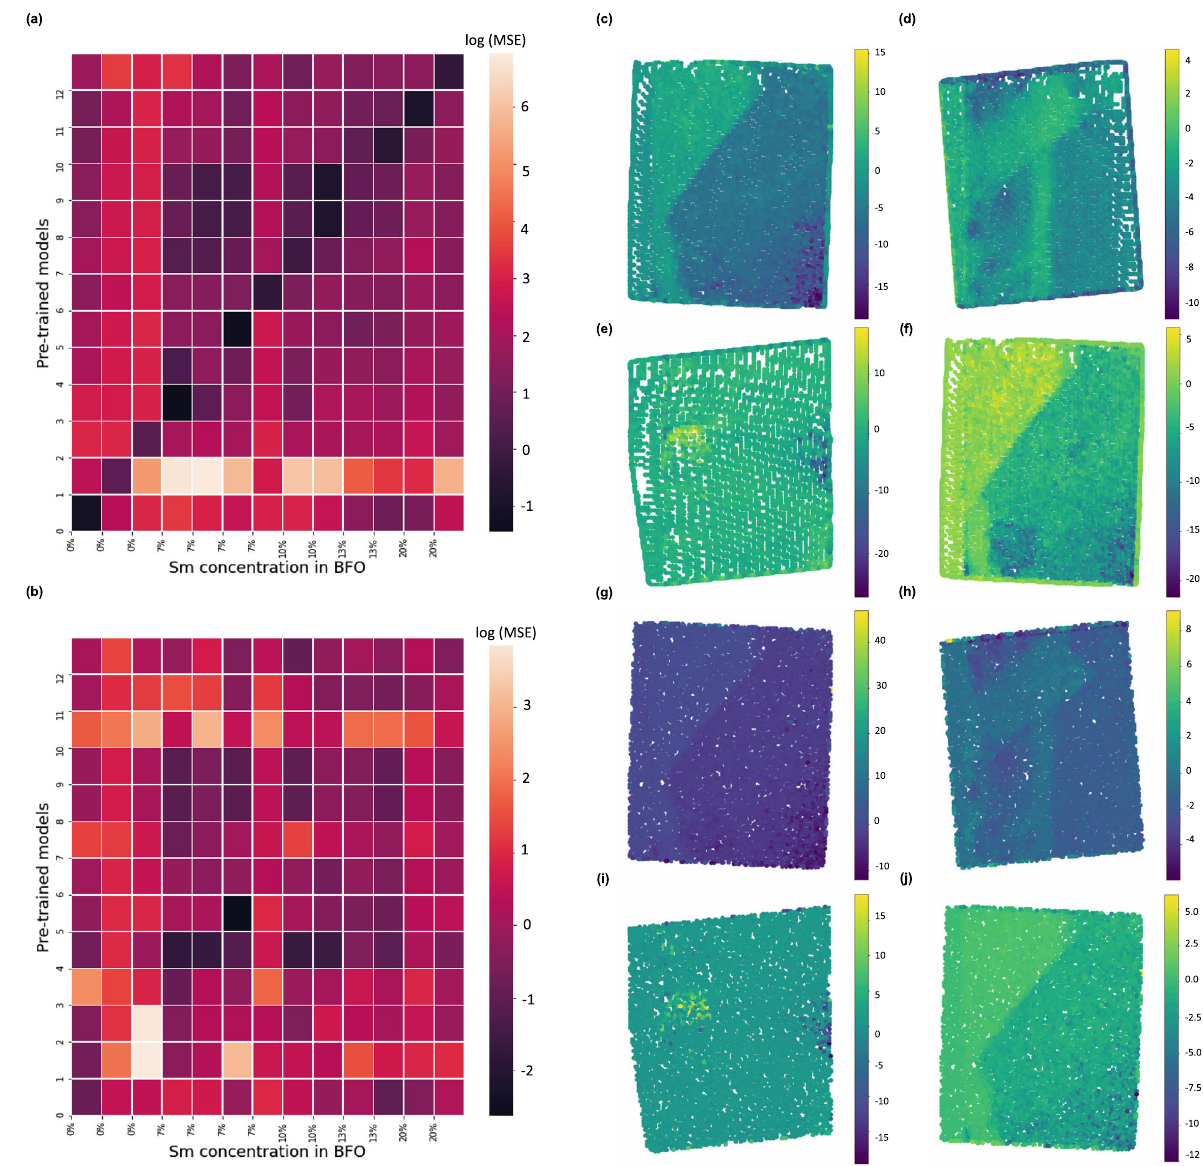
Fig. 8 Error matrices for DCNN networks. Heatmaps a and b generated by plotting MSE values as each of the 13 networks are applied to every 13 sub-image stacks. Predicted polarization maps are displayed in c – j as DCNN trained on 0% Sm is applied to 0% ( c , g ) and 7% ( d , h ) Sm sub-image stacks as well as DCNN trained on 20% Sm applied to 20% (III, VII) and 0% (IV, VIII) Sm concentrations. While a and c – f represent the errors and predicted results for NC, respectively, b and g – j are the same for